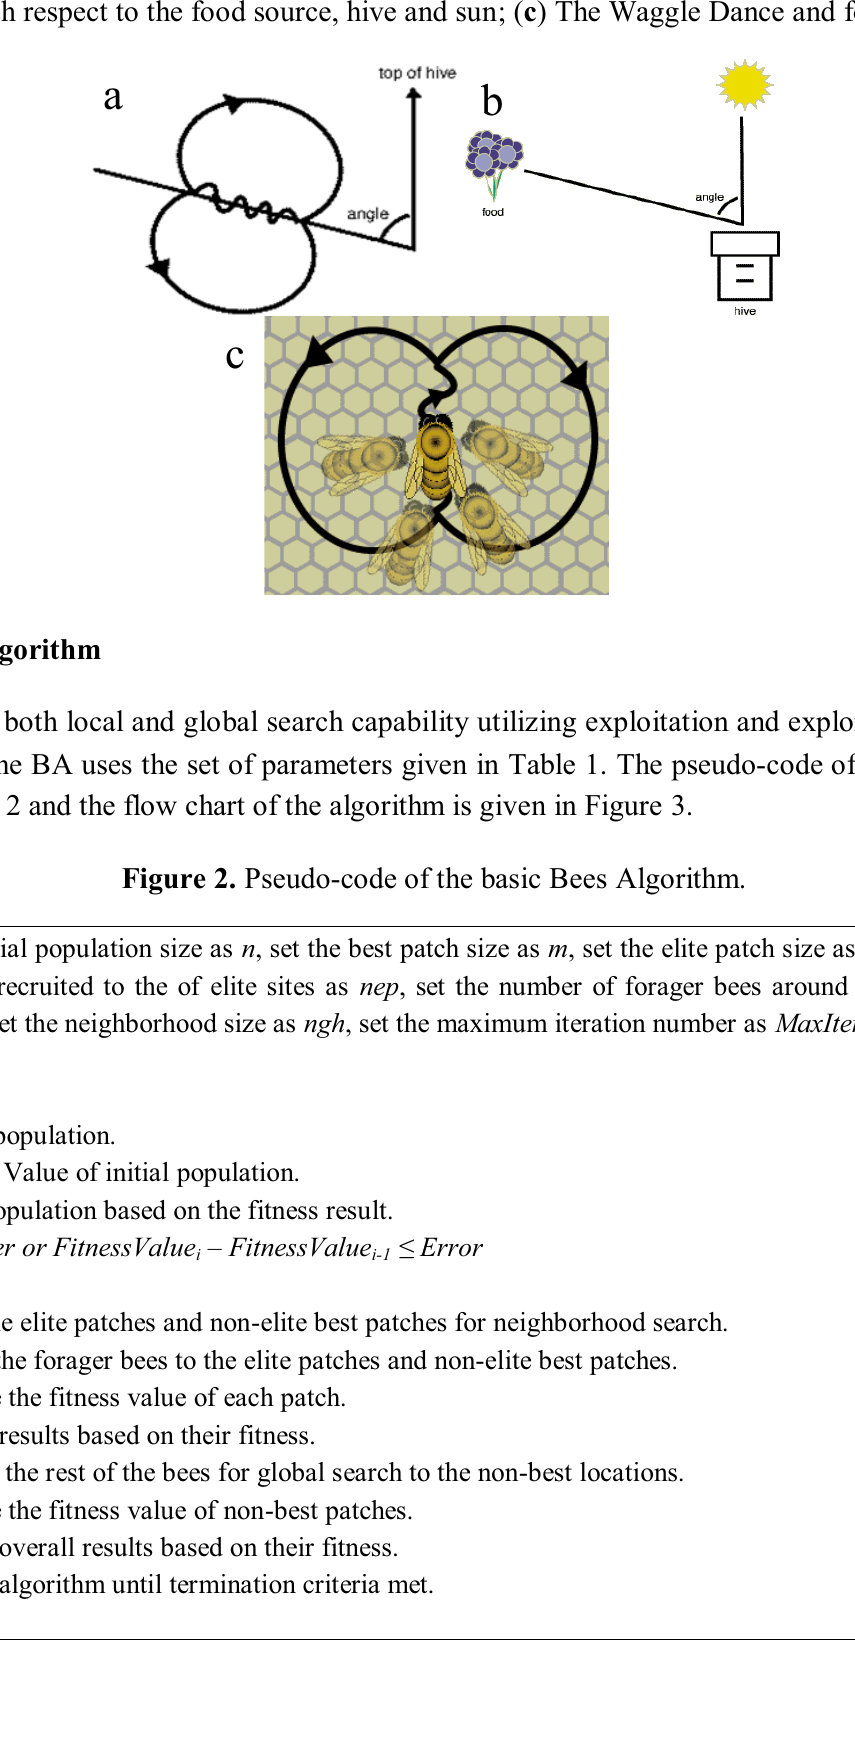
Figure 1. ( a ) Orientation of waggle dance with respect to the sun; ( b ) Orientation of waggle dance with respect to the food source, hive and sun; ( c ) The Waggle Dance and followers.